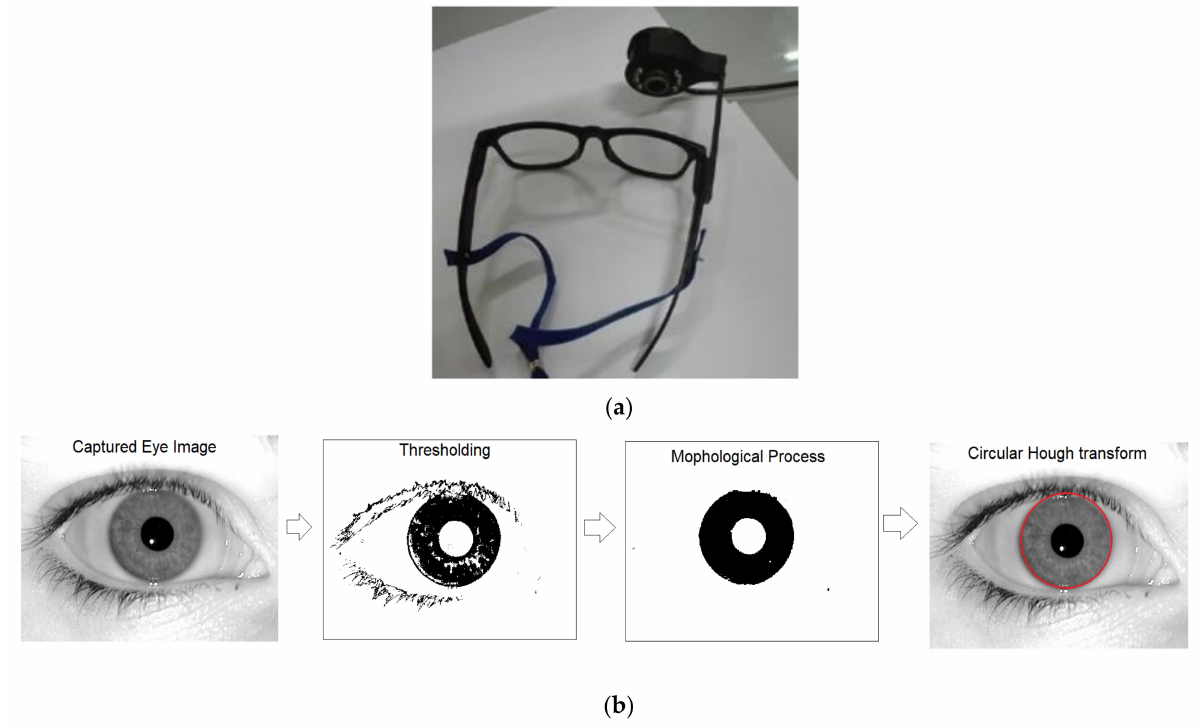
Figure 9. ( a ) Mobile assistive system eye tracker; ( b ) gaze estimation using the image processing